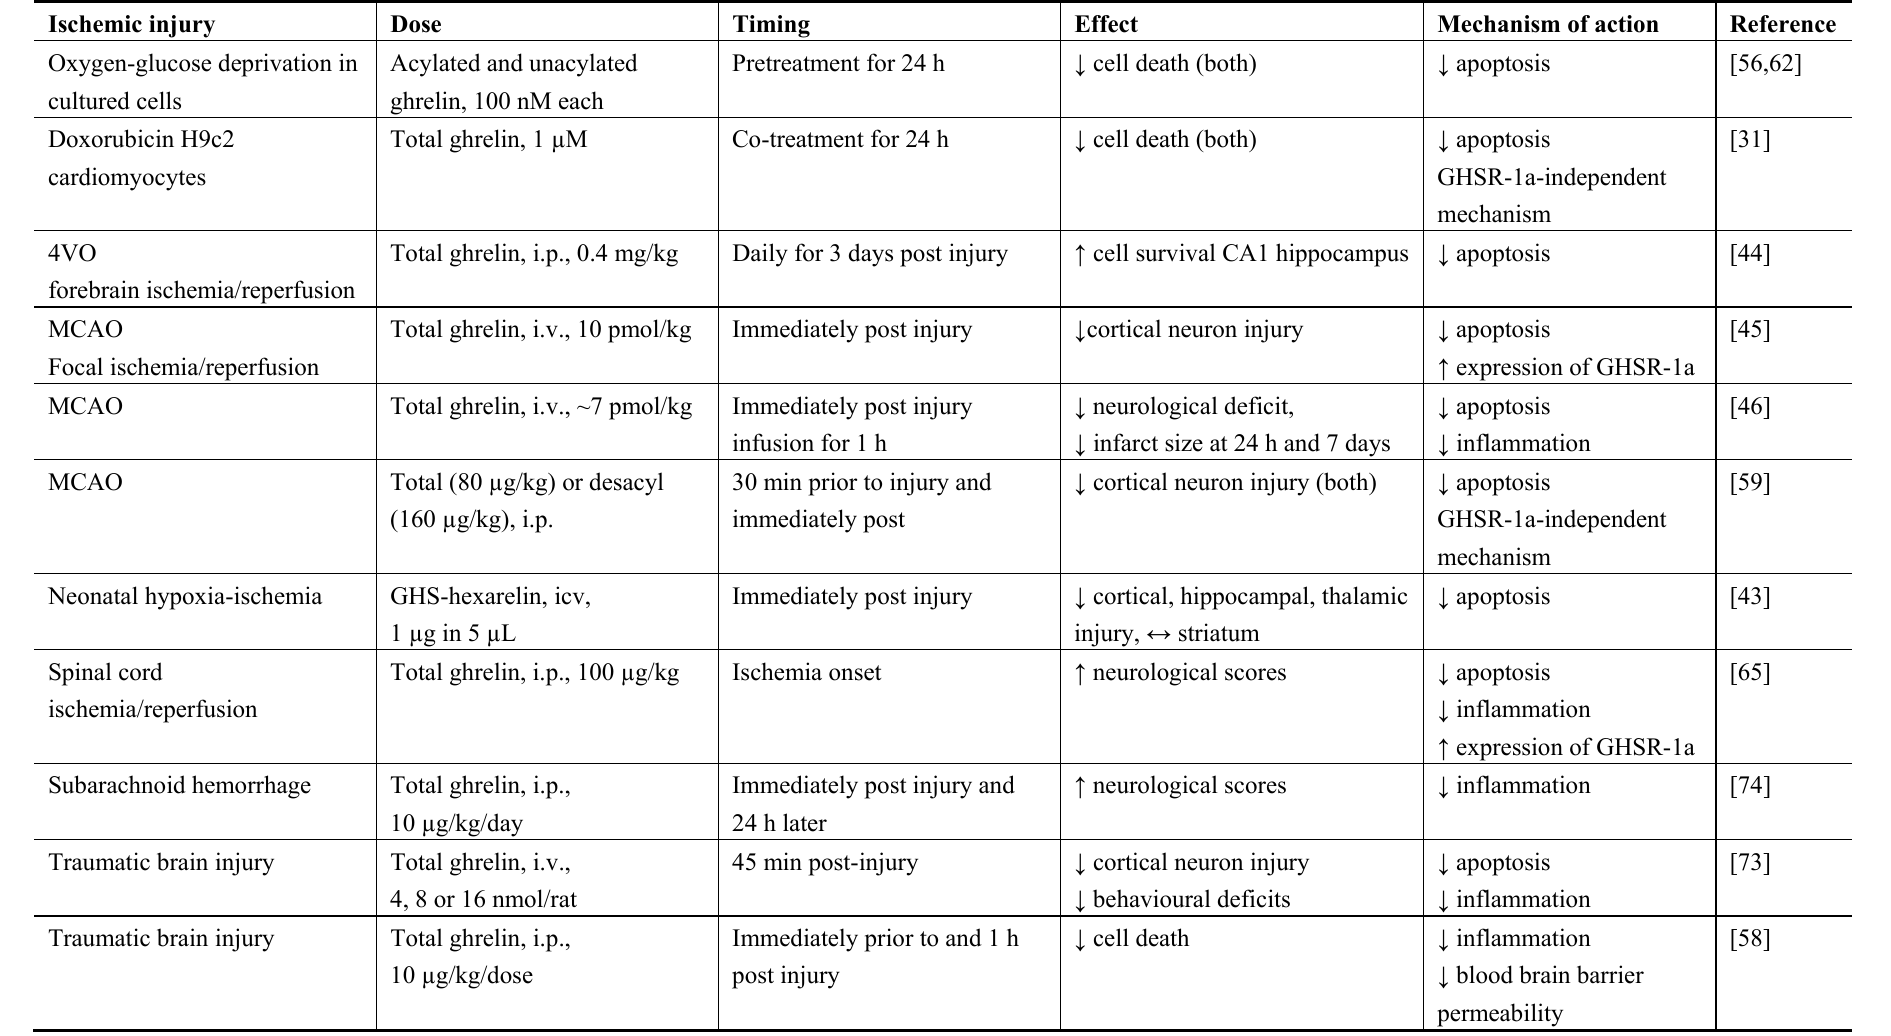
Table 1. Effects, and associated mechanisms, of ghrelin on outcomes after cerebral ischemia. All studies were conducted in rats except where indicated. Arrows are relative to vehicle-treated ischemic